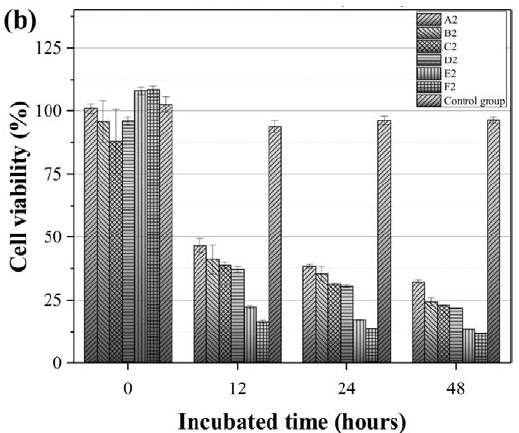
Figure 8. Melanoma cell viability following culture on the ( a ) 5 w / w % and ( b ) 10 w / w % IMQ-PCL nanofibrous meshes over 48 h ( n = 3).